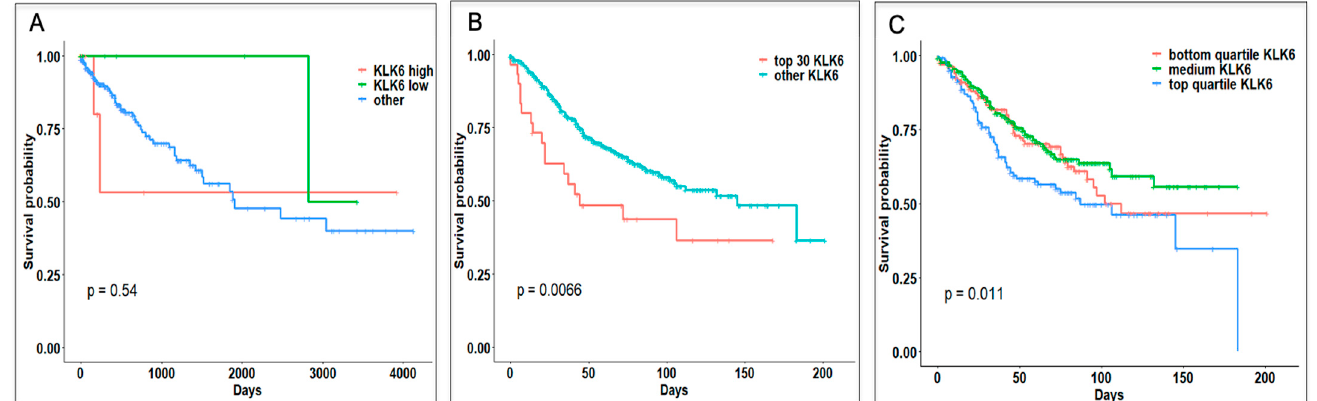
Figure 2. Overall Survival analysis of patients based on KLK6 gene expression from TCGA and GEO datasets. ( A ) Kaplan-Meier Plot of colon adenocarcinoma samples from TCGA. KLK6 High (16 samples), KLK6 low (7 samples), and others were plotted for Overall Survival. ( B ) Kaplan-Meier plot of GEO dataset for KLK6 high samples vs others. ( C ) Kaplan-Meier plot of GEO dataset: based on KLK6 gene expression, data was plotted for upper quartile, bottom quartile, and intermediate expression for overall survival.